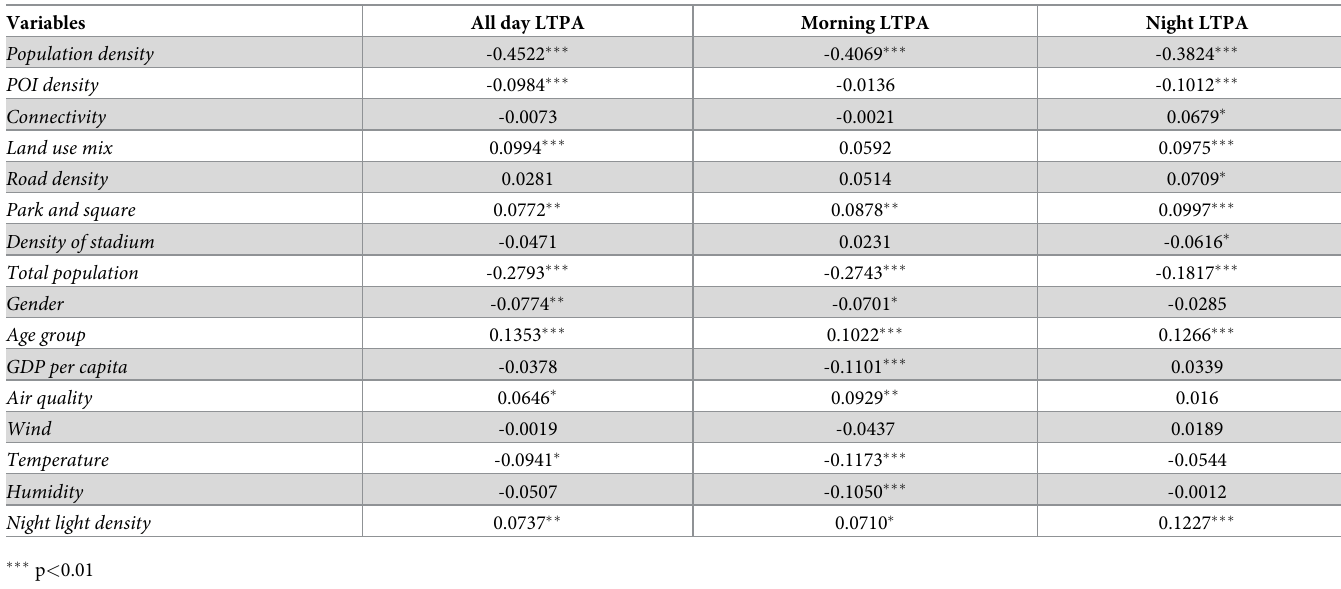
Table 3. The pairwise correlations between LTPA and influencing